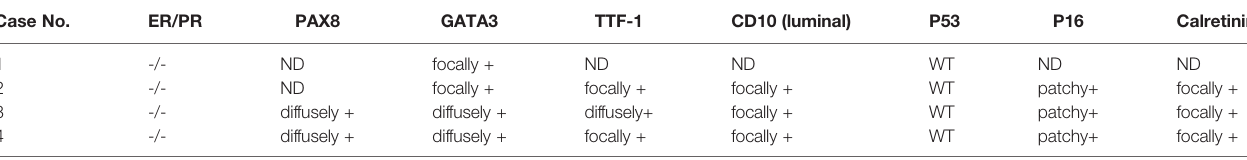
WT, wild type; ND, not done; +, positive; -,